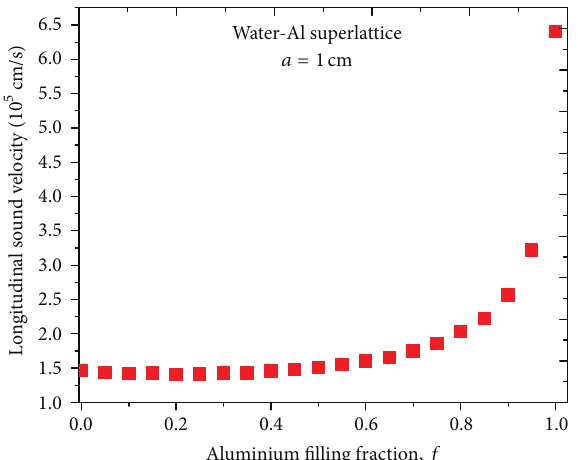
Figure 8: Dependence of the effective longitudinal sound velocity for a homogenized 1D phononic crystal of aluminium embedded in water upon the aluminium filling fraction 𝑓